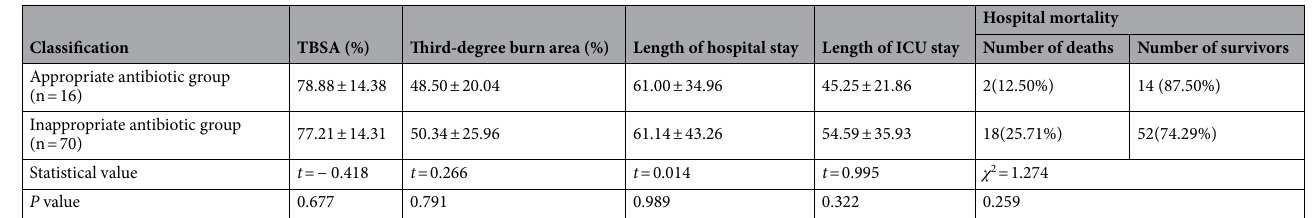
Table 9. The effect on prognosis of treatment with appropriate antibiotics before a positive blood culture was